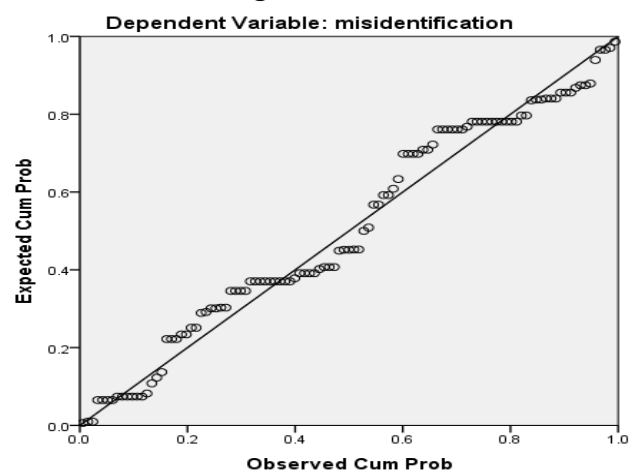
Figure 2. Normal P = plot of regression-standardized residual.